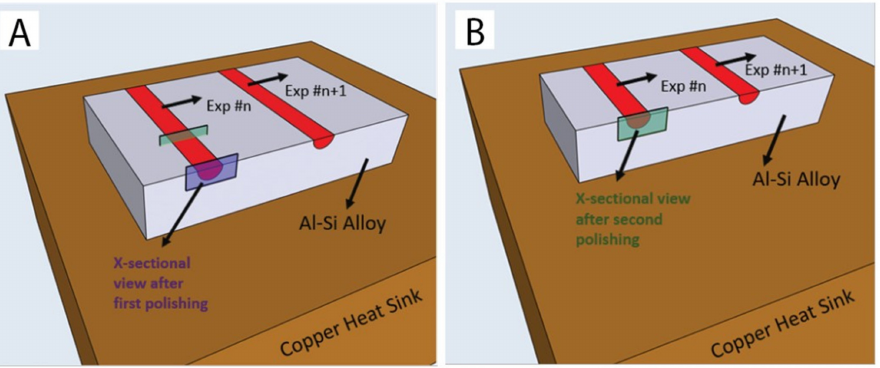
Figure 3. Schematic illustration of the cross-sectional microstructure characterization of the melt pools. Here the purple plane ( A ) was characterized first, then the block ground again and polished to get the green surface ( B ). Approximate distance between the purple and green plane is 100 µ